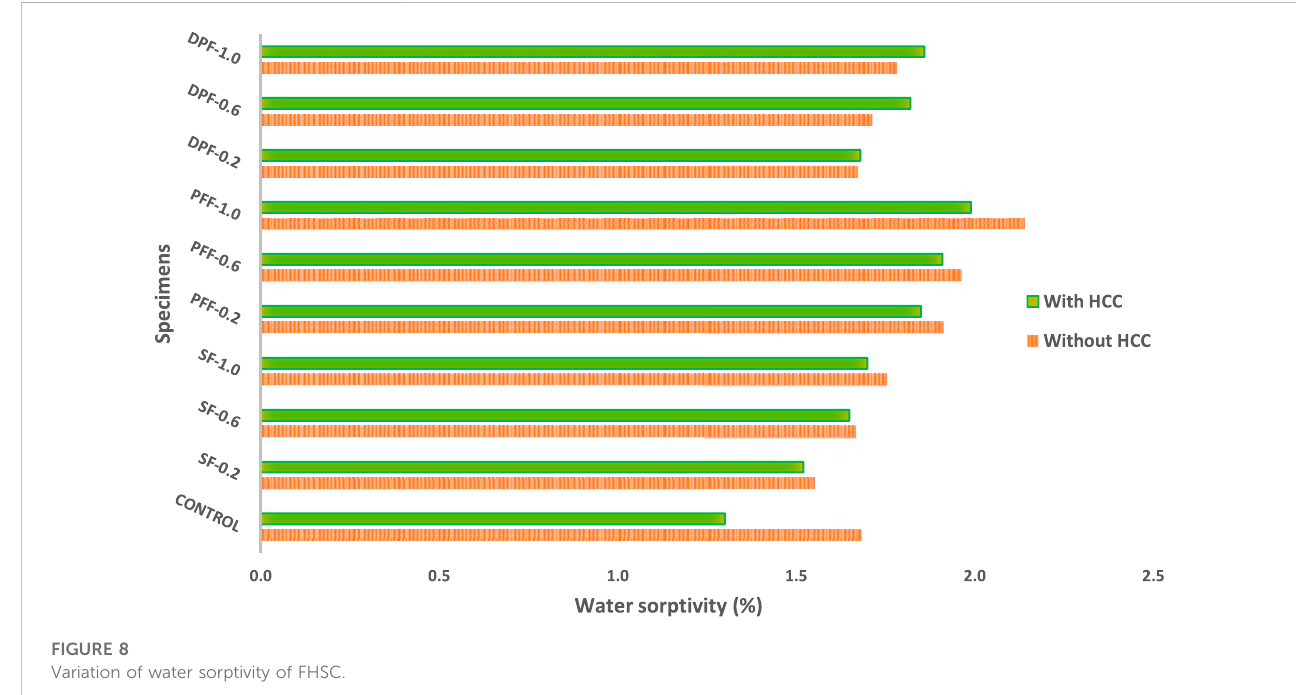
FIGURE 8 Variation of water sorptivity of